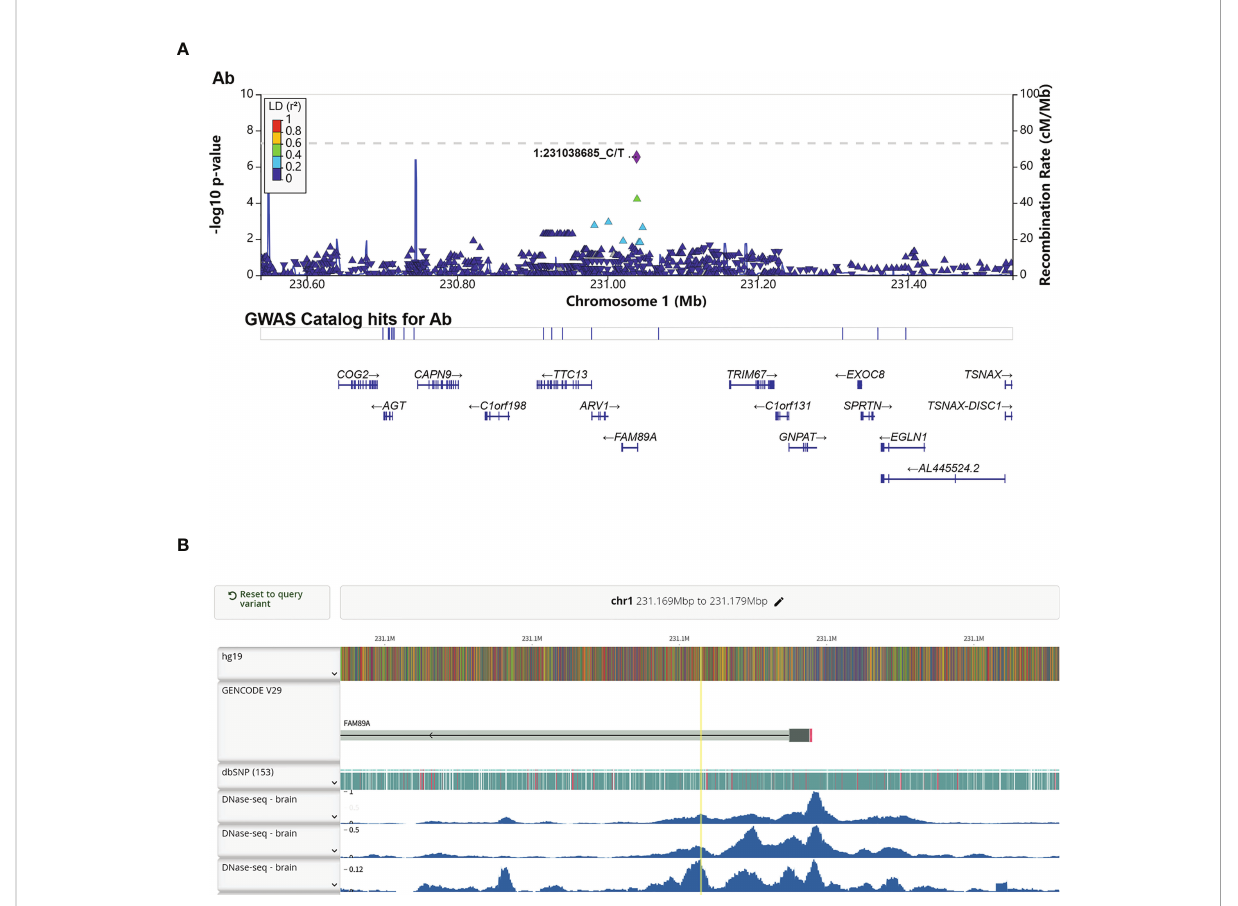
FIGURE 3 Annotation of the signi fi cant association SNP rs4543780. (A) LocusZoom plot showed the P value of the SNPs centering the lead SNP rs4543780, linkage disequilibrium degree, the recombination rate (top panel), SNP hits in GWAS catalogue (middle panel) and the genes in the